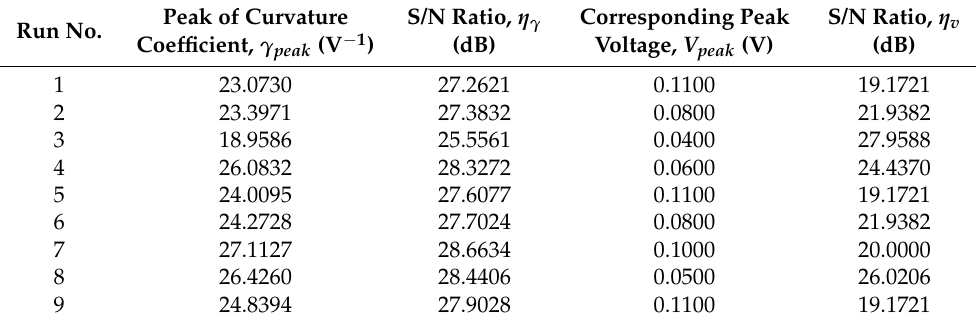
Table 3. Curvature coefficient from simulated IV characteristics and corresponding S/N ratio for each run. Run No.